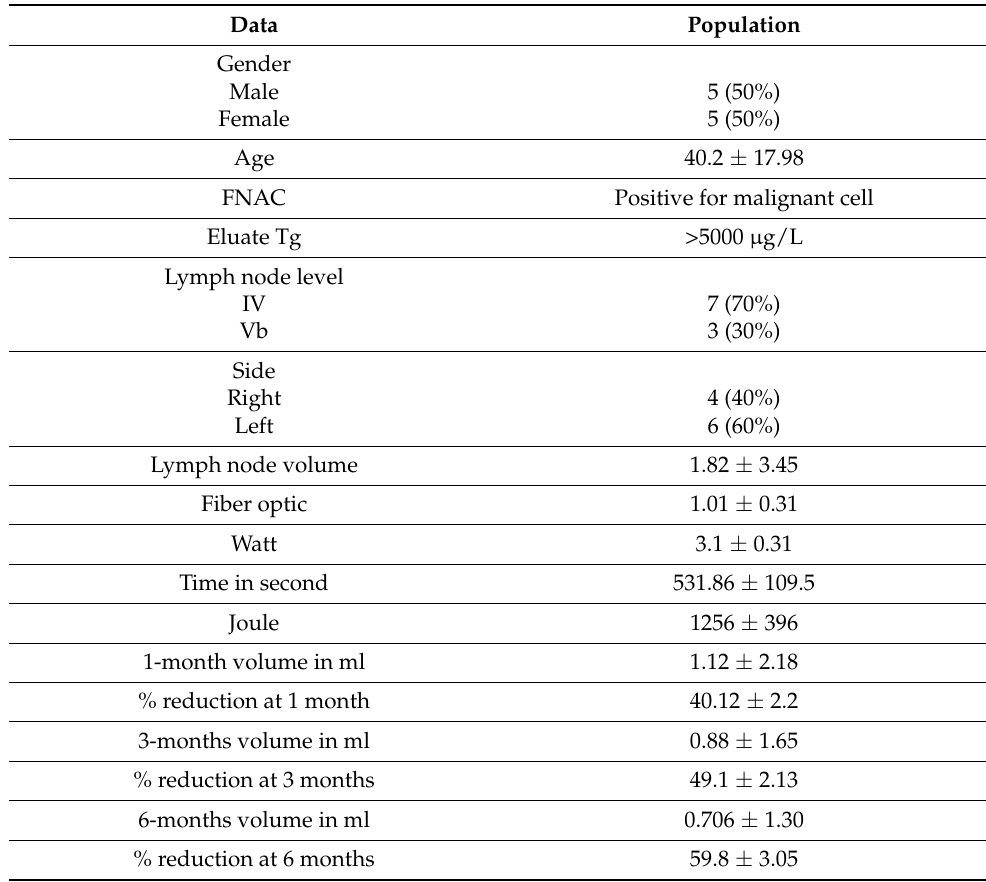
Table 1. Demographic and clinical data of the study population (FNAC, fine needle aspiration cytology; Tg, thyroglobulin; mL, milliliter).